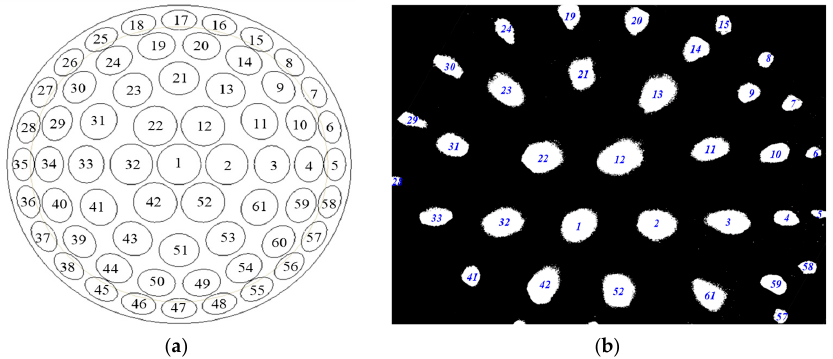
Figure 10. Multi-eye positioning experiment: ( a ) sub-eye lens number; and ( b ) sub-eye acquisition image.